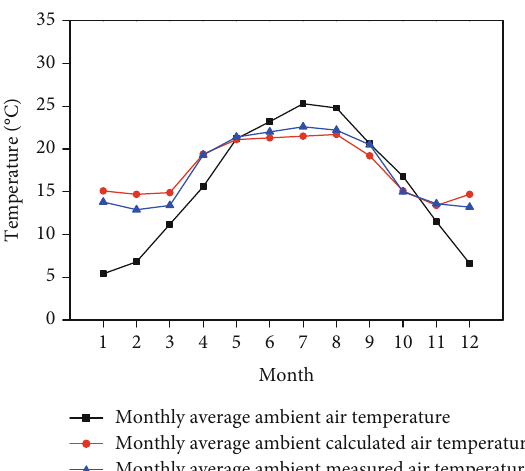
Figure 7: Heat transfer process of mode 2.